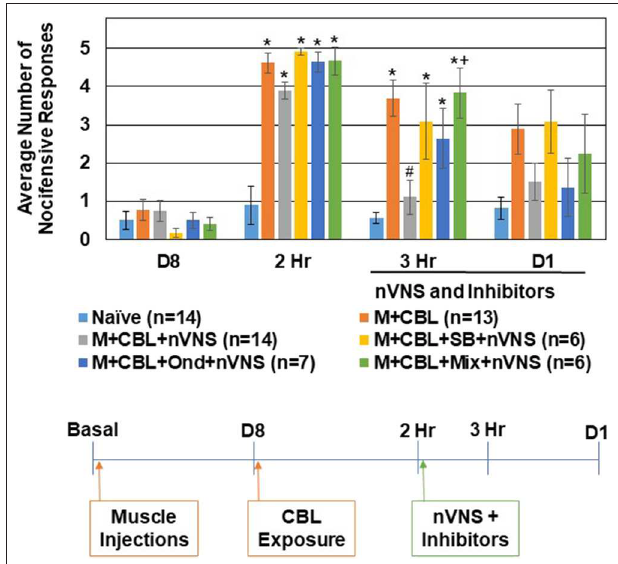
FIGURE 4 | Anti-nociceptive effect of nVNS involves 5-HT3 and 5-HT7 receptors. The average nocifensive head withdrawal response ± SEM of 5 applications to each side to mechanical stimuli are reported. Some animals were left untreated (Naïve), some were injected with complete Freund’s adjuvant 8 days prior to exposure to a pungent extract from California Bay Laurel leaves (M + CBL) and nociceptive responses determined at 2h, 3h, and 1 day post CBL exposure. Some of the M + CBL animals were treated with Ondansetron, SB 269970, or a mixture (Mix) prior to nVNS and nociception measured 1h and 1 day post treatment. * P < 0.05 when compared to Naïve while # P < 0.05 compared to M + CBL. + P < 0.05 when compared to M + CBL +